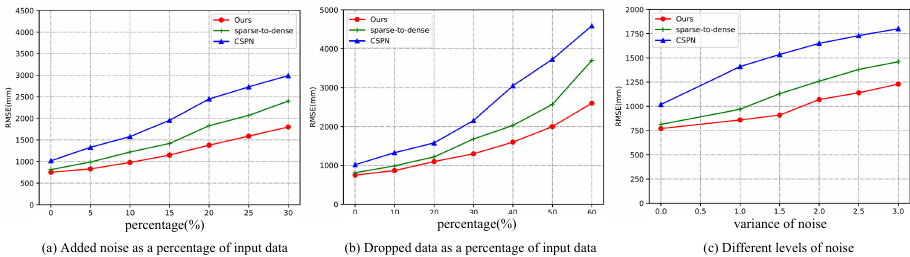
Figure 4. The robustness was tested using the validation dataset of the KITTI depth completion benchmark (Net1 architecture): ( a ) the randomly added noise as a percentage of the input data; ( b ) the randomly discarded data as a percentage of input data; ( c ) the addition of varying degrees of noise to 10 percent of the input data (0 means no noise was